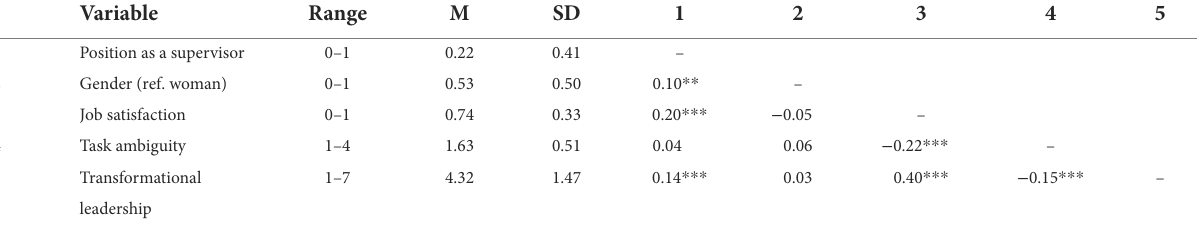
TABLE 1 Means, SD, and correlations for variables in Study 1.